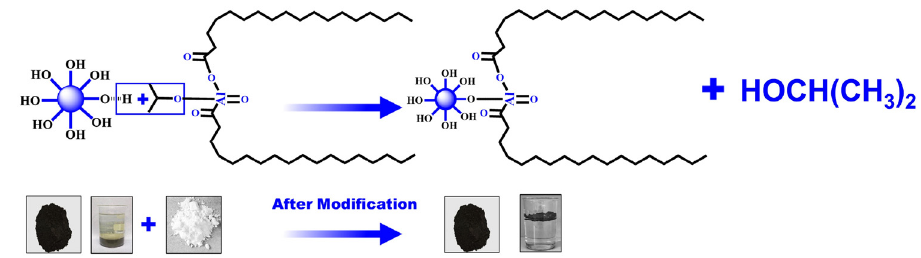
Figure 2: Schematic of the CFA modi fi cation process.